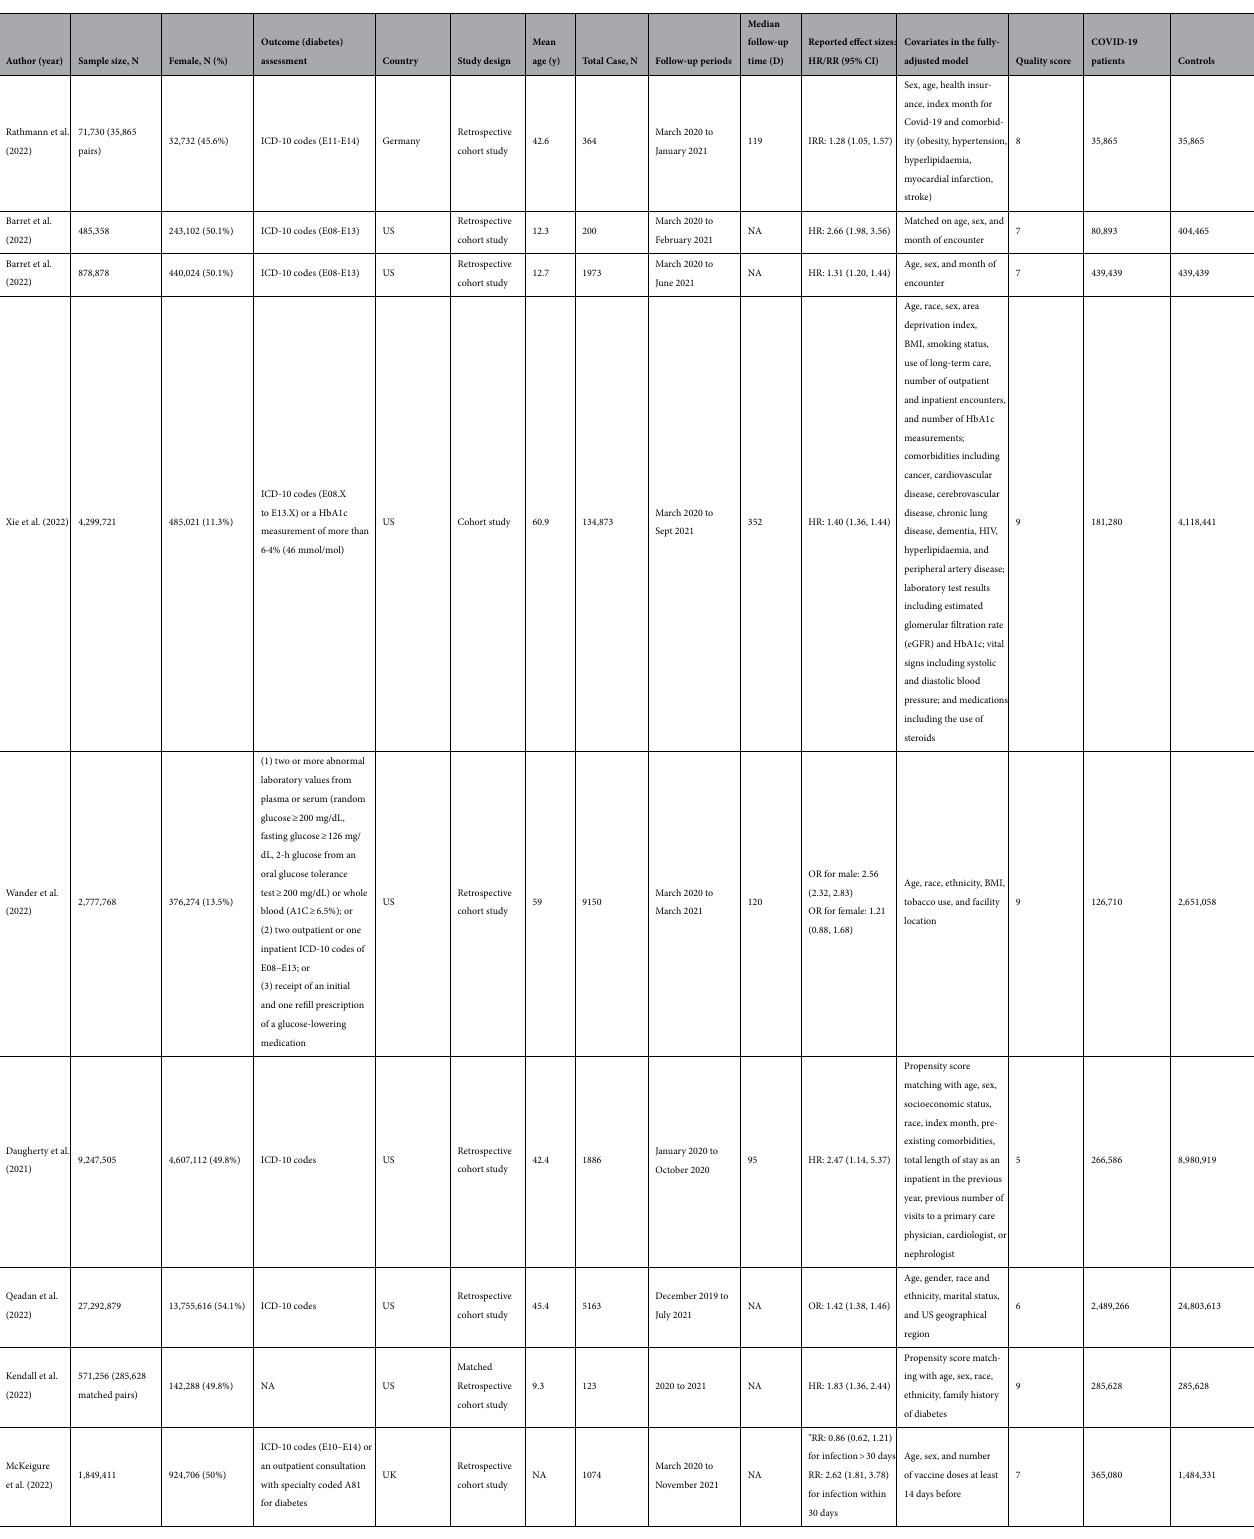
Table 1. Meta-analysis characteristics of included cohort studies reporting COVID-19 and risk of diabetes. some individuals in the control groups could have had undetected mild or asymptomatic COVID-19 because they had not been tested. Such non-differential misclassification of the exposure may underestimate the strength of the association of COVID-19 with the onset of diabetes. Lastly, due to the limited number of studies included in the present meta-analysis, we did not categorize the risk by the type of diabetes such as type 1 and type